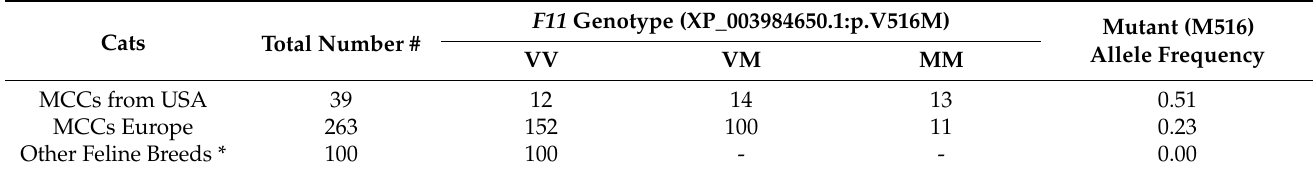
Table 1. Comparison of F11 mutant allele frequencies in Maine Coon cats from the USA and Europe, and other cat breeds in Europe assessed by Taqman ® SNP Genotyping